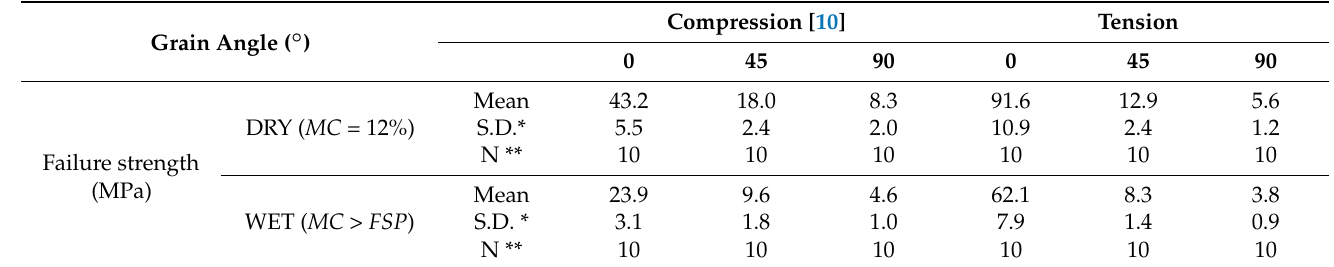
Table 5. The failure strengths of E. nitens timber in both dry ( MC = 12%) and wet ( MC = 66% > FSP ) conditions at grain angles of 0 ◦ , 45 ◦ , and 90 ◦